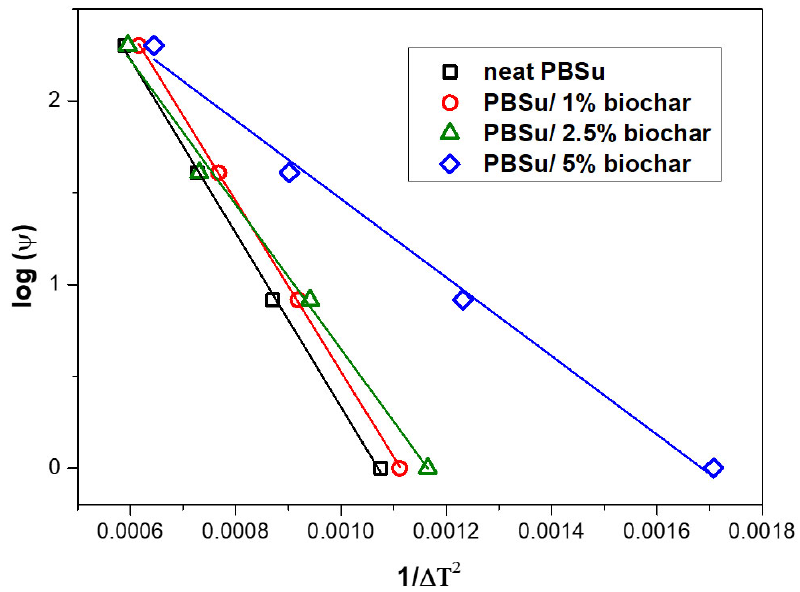
Figure 5. Plots of log ψ versus 1/ ∆ T 2 for neat PBSu and PBSu/biochar composites filled with various fi ller content.